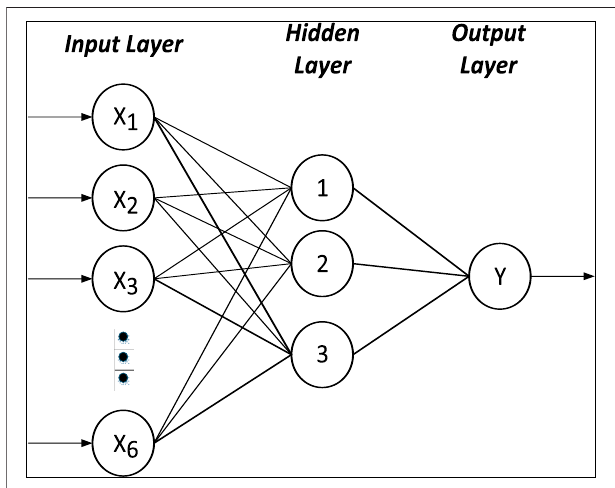
FIGURE 3 | DA-DOPF fl ow